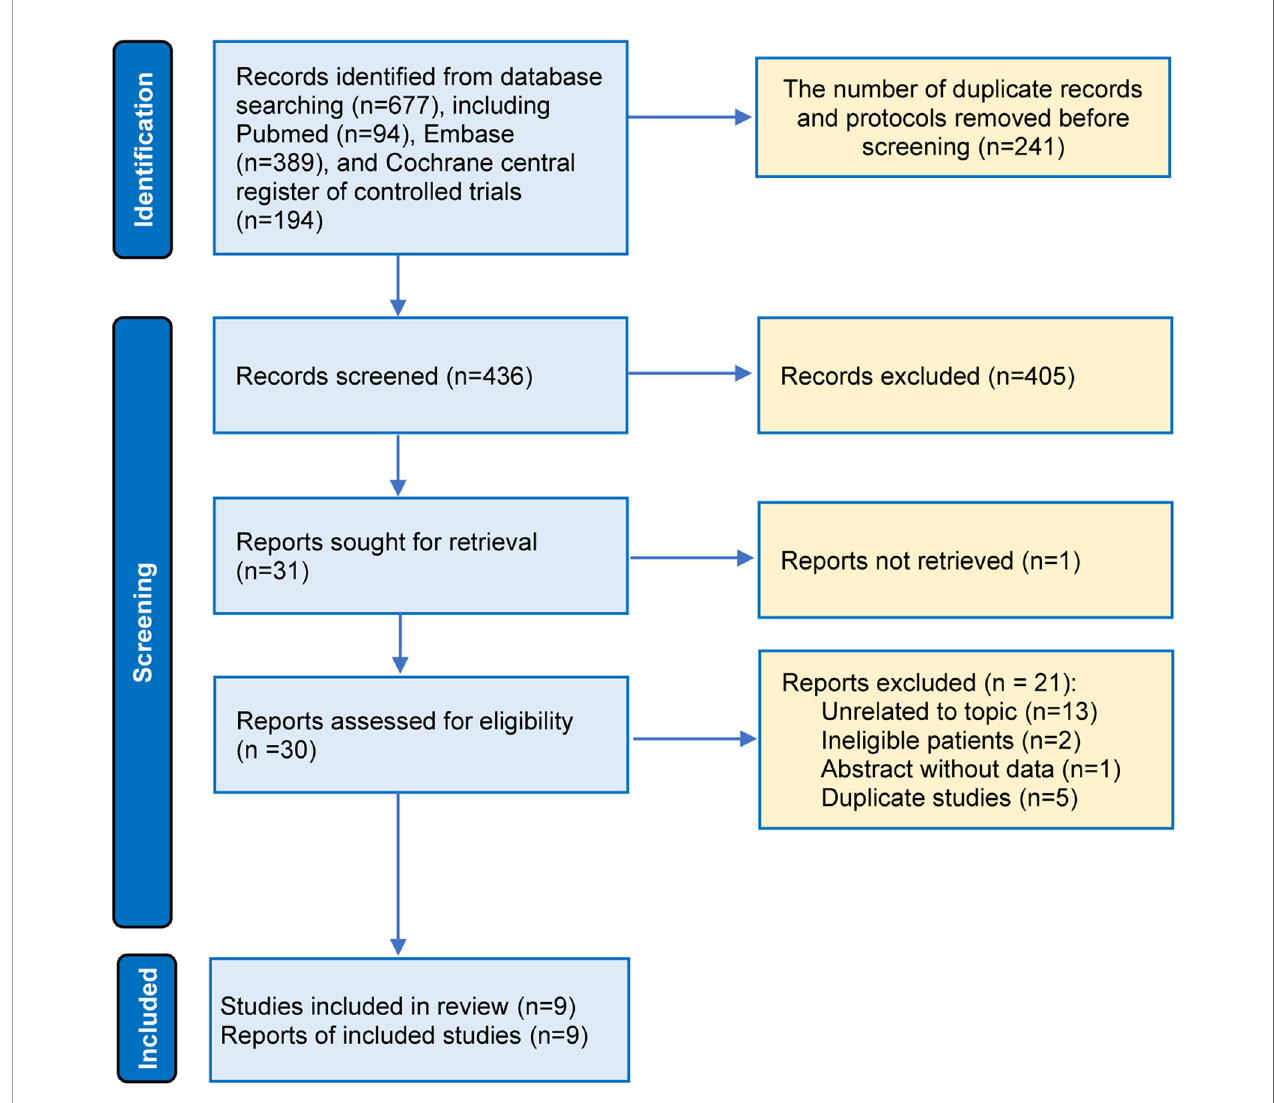
FIGURE 1 | Flow diagram of the study retrieval and